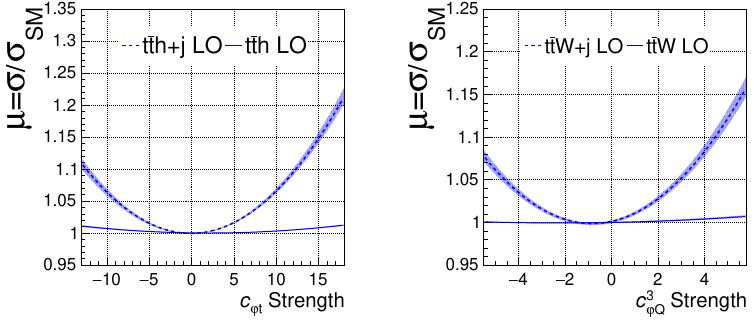
Figure 12 . Systematic uncertainties on the inclusive t¯th and t¯th+j cross sections for c ϕ t and the inclusive t¯tW and t¯tW+j cross section for c 3 . Both t¯tX and t¯tX+j curves are normalized to the ϕQ SM as discussed in the text, and both curves include the uncertainty band, but the uncertainties on the t¯tX curve are too small to be seen on this plot. We note that the size of the uncertainties are much smaller than the size of the effect of including an extra parton. As described in the text, the range for each Wilson coefficient is taken from the marginalized limits presented in ref.